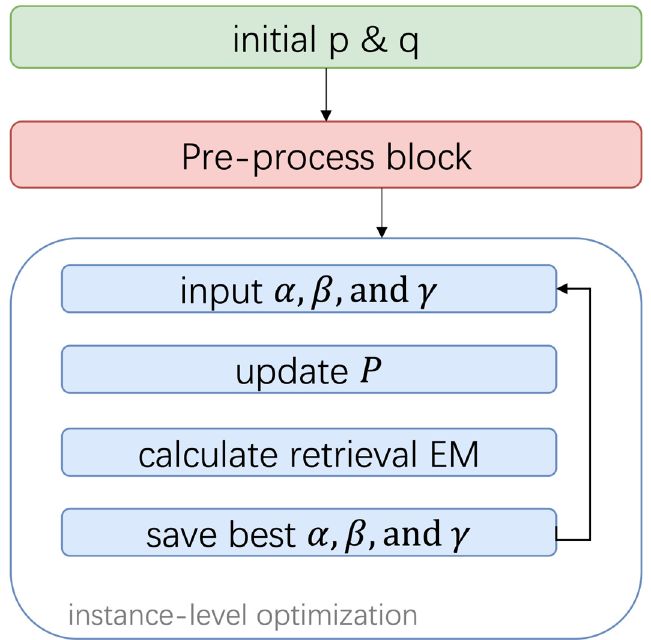
Figure 3. Flowchart for Updating Text Representations Based on Linear Weight Calculation.